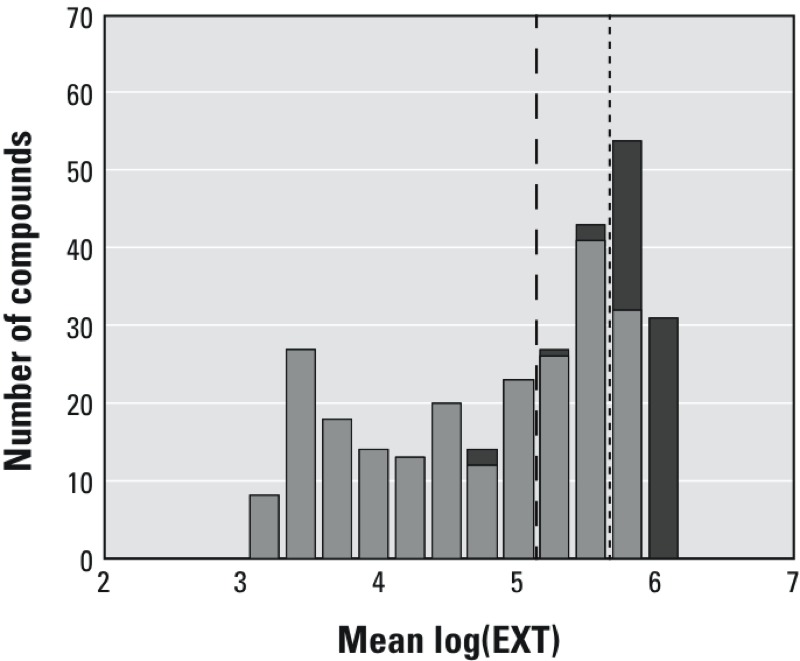
Comparison between t-test and effect size threshold. The histogram presents the number of chemicals in each size class [mean log(EXT)]. The dark gray bars indicate the number of inactive compounds in each size class according to the weighted t-test, and the light gray bars indicate the number of compounds determined to be active in each size class. The two vertical lines indicate the maximum log(EXT) for nematodes ≤ L3 (5.138) and the minimum log(EXT) (5.665) for L4 and young adult nematodes (see Figure 1). Chemicals between the vertical lines had weighted mean Log(EXT) values consistent with a mixture of L3s and L4s.